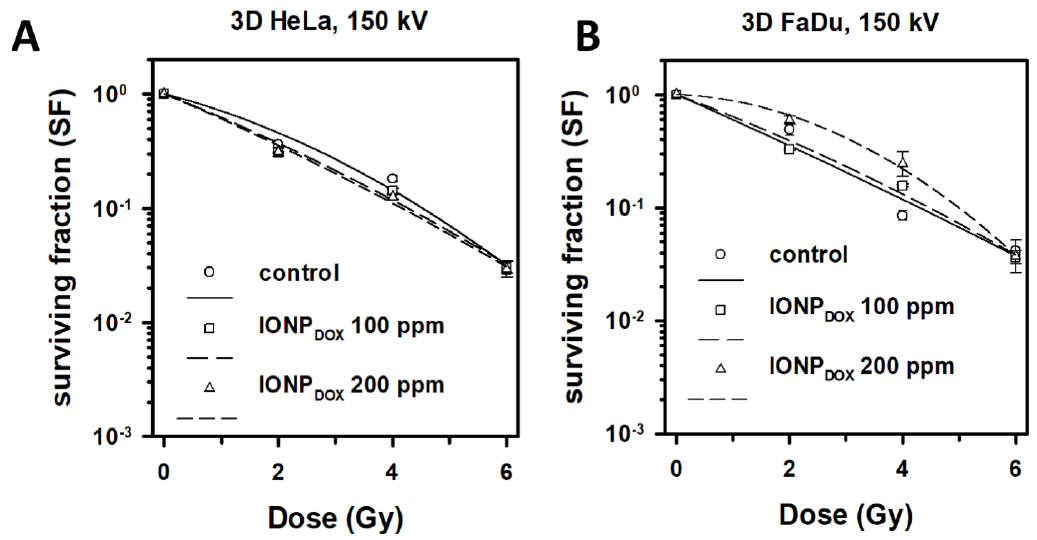
Figure 10. Clonogenic survival of 3D cultured cells exposed to 0, 100 and 200 μg/ mL IONP DOX for 48 h, followed by 150 kV X-ray irradiation at different doses; results are shown as mean ± STDEV (n = 3): ( A ) HeLa cells, ( B ) FaDu cells.